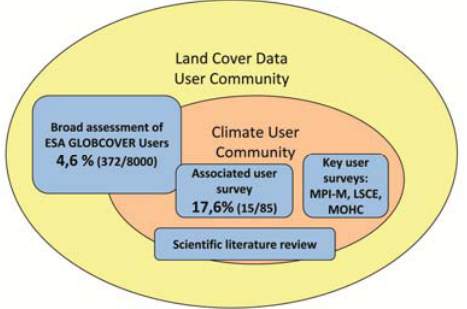
Figure 1. User consultation mechanism established to assess LC requirements. Percentages indicate the number of responses received from each user’s group